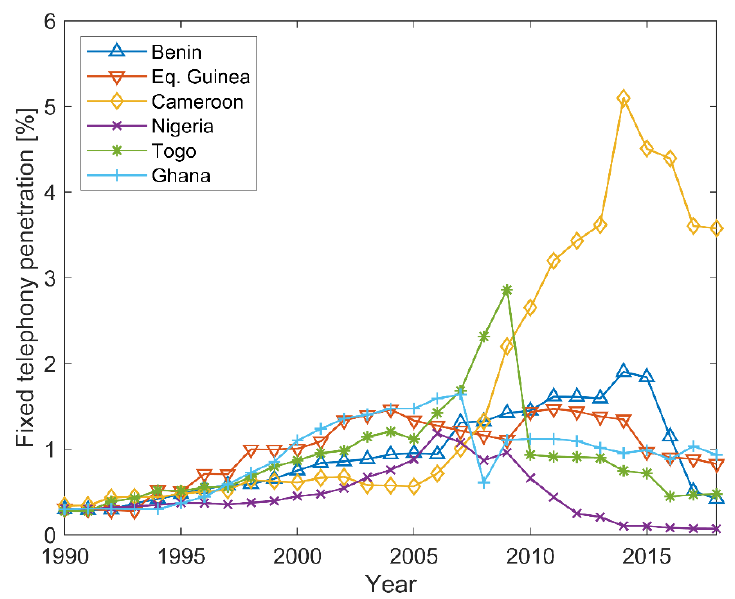
Figure 1. Fixed telephony penetration in the Gulf of Guinea (based on data available from [25]). From the aforementioned it is clear that fixed telephony cannot be chosen as a pri- mary communication network for maritime sensor network in this part of the World, es- pecially when it comes to uninhabited and inaccessible areas.